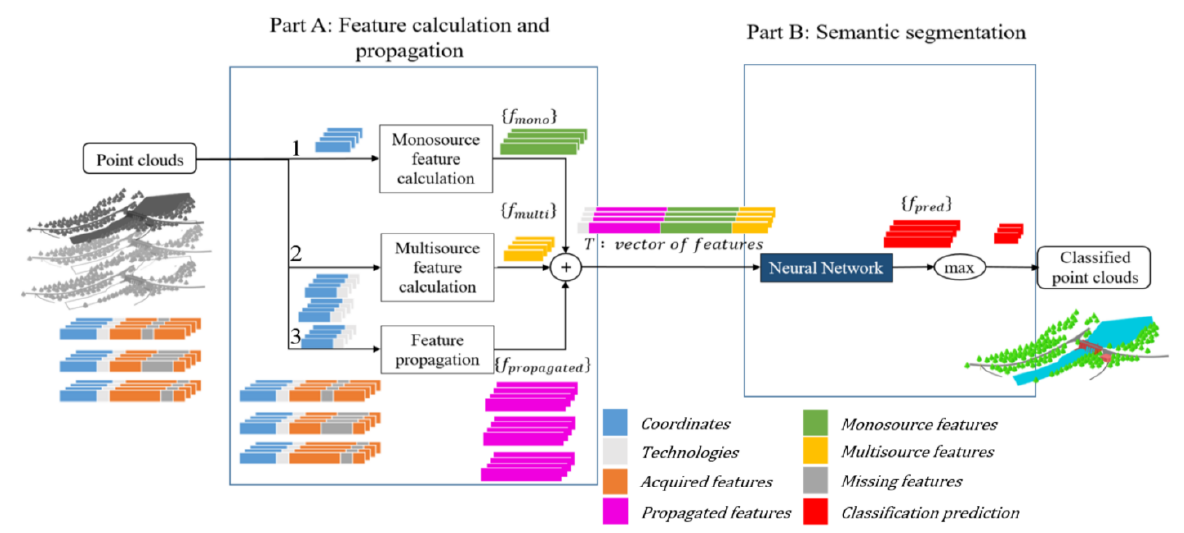
Figure 1. Flowchart of the method, with the representation of a point vector and the color